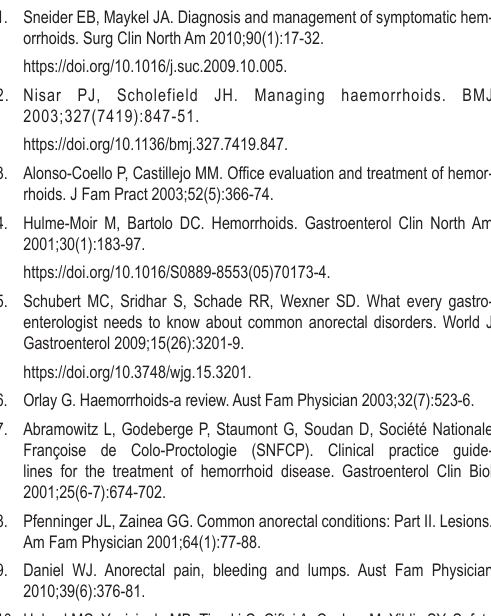
TABLE 3. Participants according to the number of the symptoms of hemorrhoid disease before and after the therapy Number of patients with a different number of symptoms of hemorrhoid disease Before the therapy (%) After the therapy (%) Patients with 4 symptoms Patients with 3